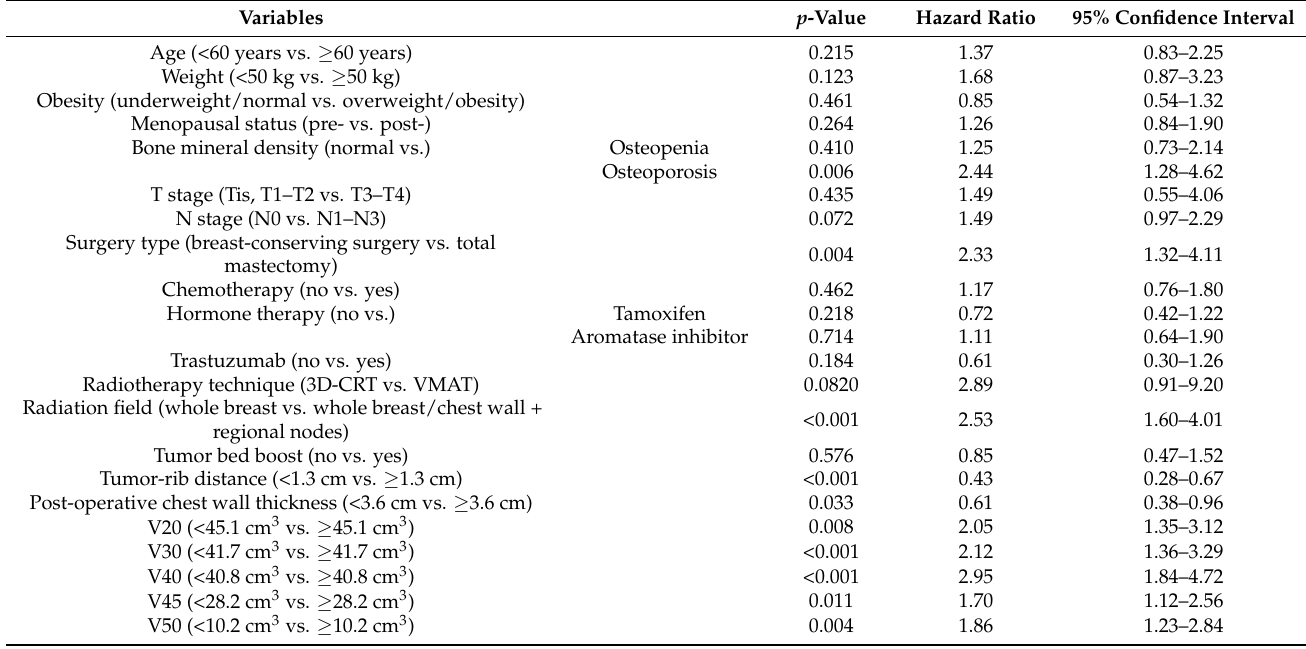
Table 3. Univariate analysis of risk factors of radiation-induced rib